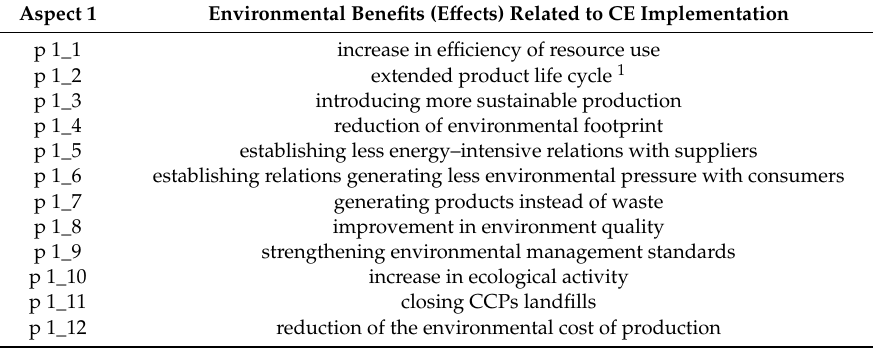
Table 2. Summary presentation of the aspects assessed in the